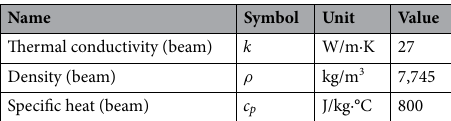
Table 5. Thermo-physical properties of a beam.